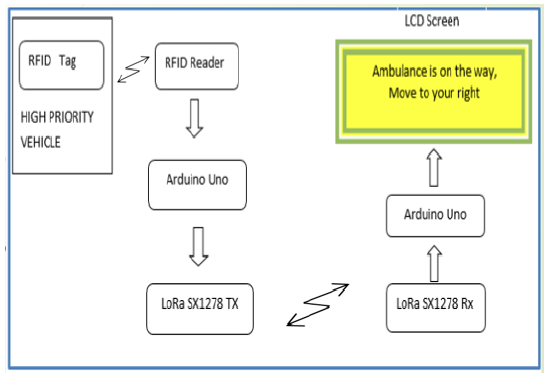
Fig. 1. Block diagram of the proposed